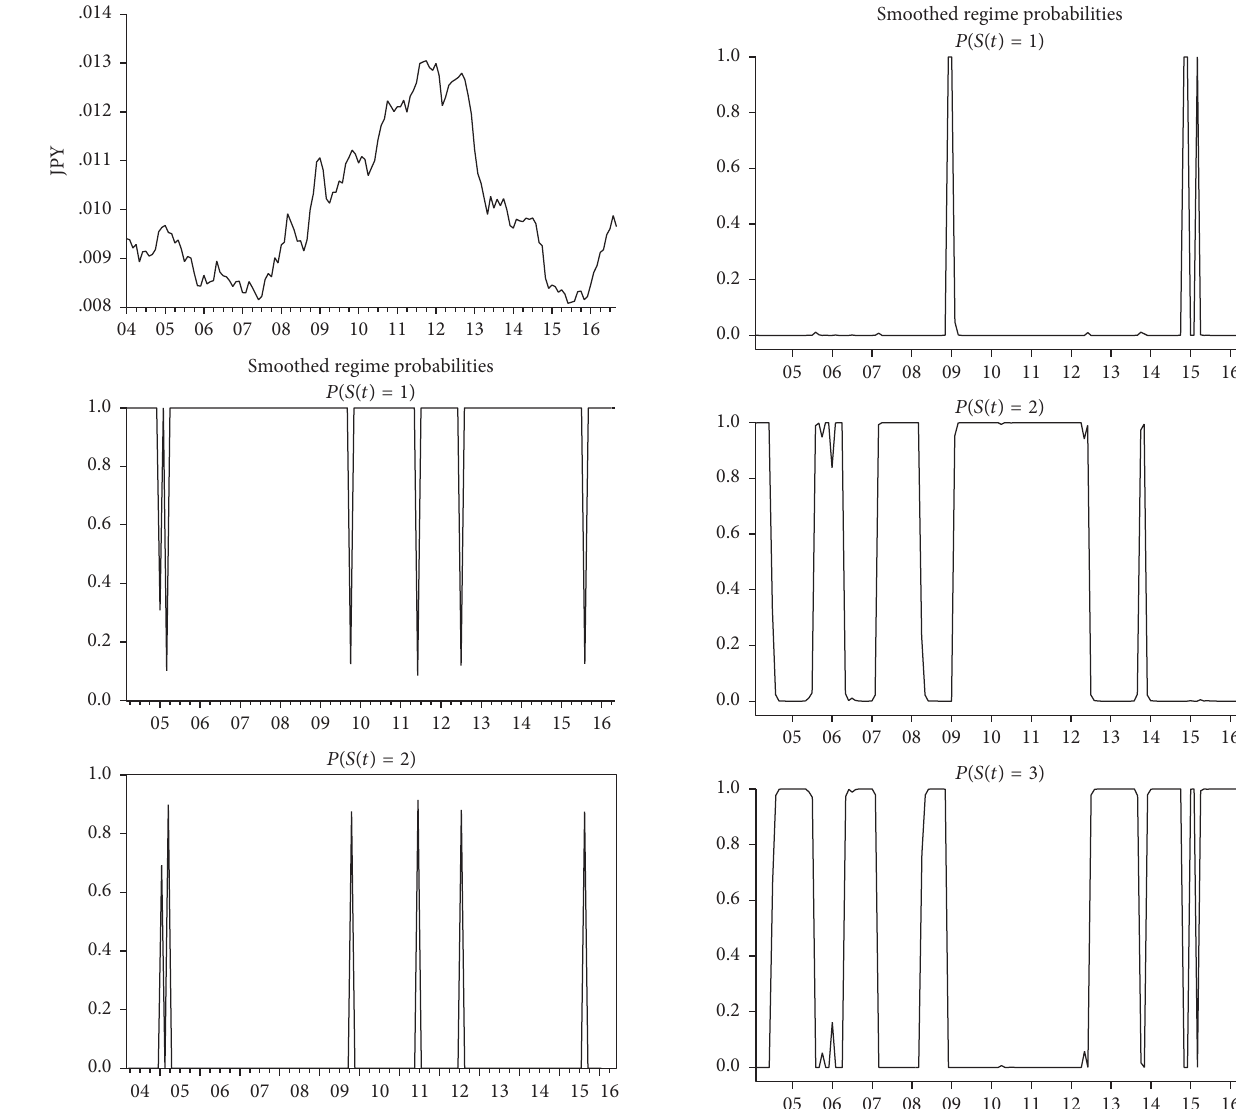
Figure 6: Smoothed probability plots of USD/NGN for 2004M01–